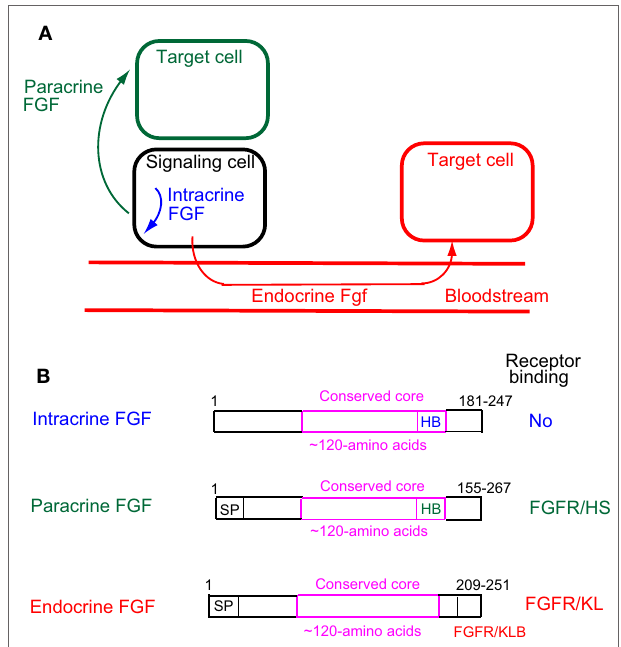
FiGURe 1 | (A) Action mechanisms of FGFs. FGFs act on target cells in an intracrine, paracrine, or endocrine manner. (B) Schematic representations of FGF structures. SP, HB, and FGFR/KB indicate a secreted signal sequence, heparan sulfate-binding site, and FGFR/Klotho complex-binding site,